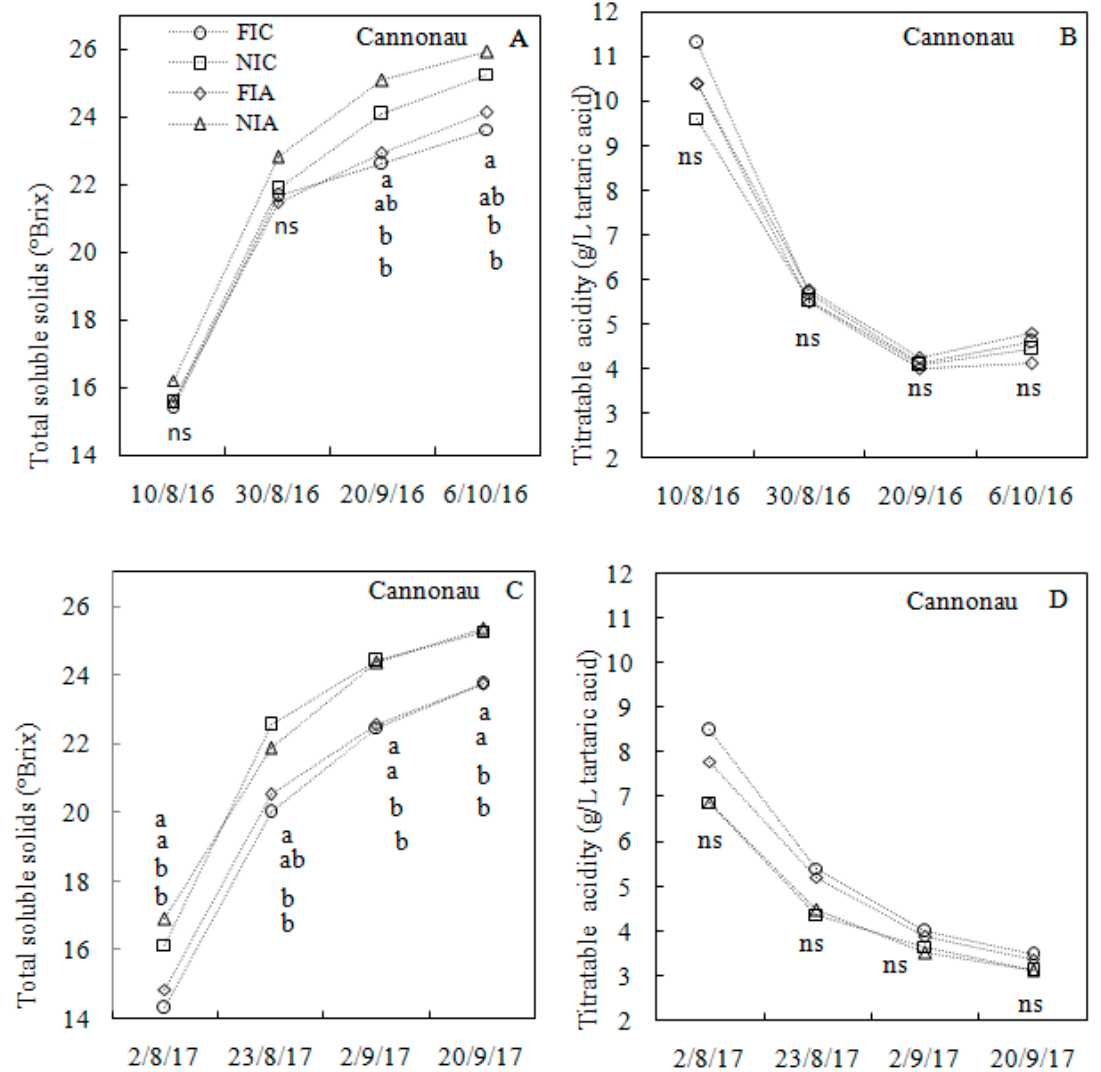
Figure 6. Seasonal variations of grape total soluble solids in 2016 ( A ) and 2017 ( C ) and titratable acidity in 2016 ( B ) and 2017 ( D ) in cv. ‘Cannonau’. FIA = full irrigation ( + ) ABA; FIC = full irrigation ( − ) ABA; NIA = no irrigation ( + ) ABA; NIC = no irrigation ( − ) ABA. The different letters indicate statistical significance at P < 0.05 using the LSD test. ns = not significant.